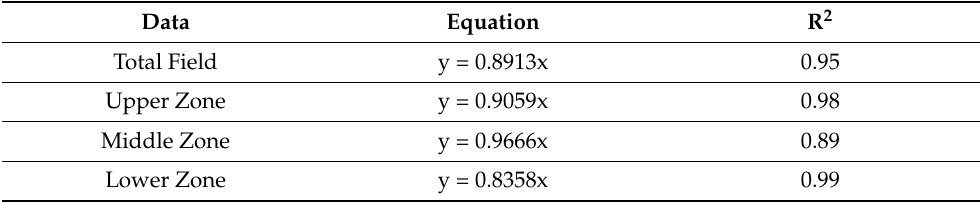
Figure 7. Field versus simulated yield for the plots selected for validation. Table 9. Correlation of measured (y) and simulated (x) Table 6. Results of calibration simulations (kg/ha) using fertility as adjustment parameter. Average fertility for each zone treatment (Blocks 2 and 3).